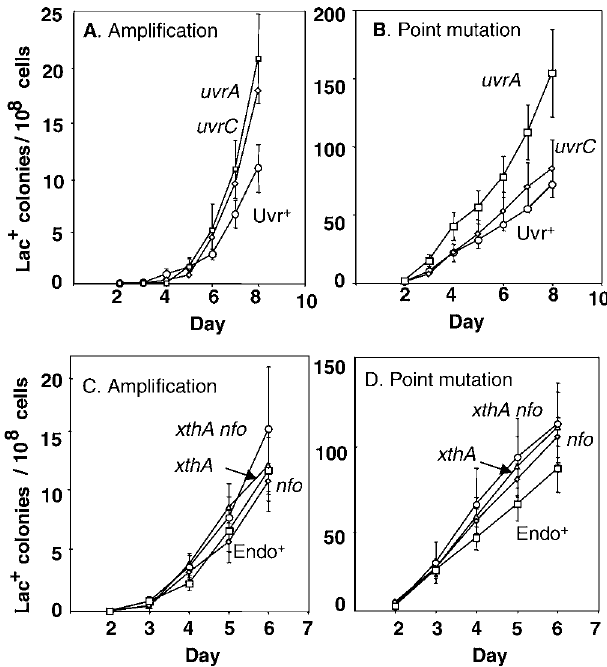
Figure 6. NER and BER Are Not Involved in Adaptive Amplification (A) Deletions of uvrA and uvrC, essential components of NER, do not depress adaptive amplification, or (B) point mutation. The associated strains are as follows: Uvr þ (circles), SMR4562; uvrA (squares), PJH357; and uvrC (diamonds), PJH358. (C) Inactivation, singly or together, of xthA and nfo genes encoding ExoIII and EndoIV, redundant AP-endonucleases required for BER, does not depress adaptive amplification, or (D) point mutation. Strains used are as follows: Endo þ (squares), SMR4562; xthA (triangles), SMR5796; nfo (diamonds), SMR4558; and xthA nfo (circles), SMR5952. DOI: 10.1371/journal.pgen.0020048.g006